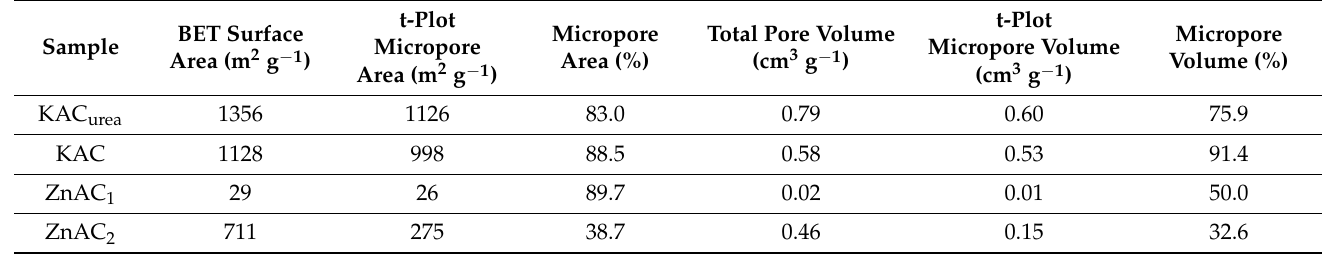
Table 1. Surface area and pore analysis parameters for the GM-derived AC